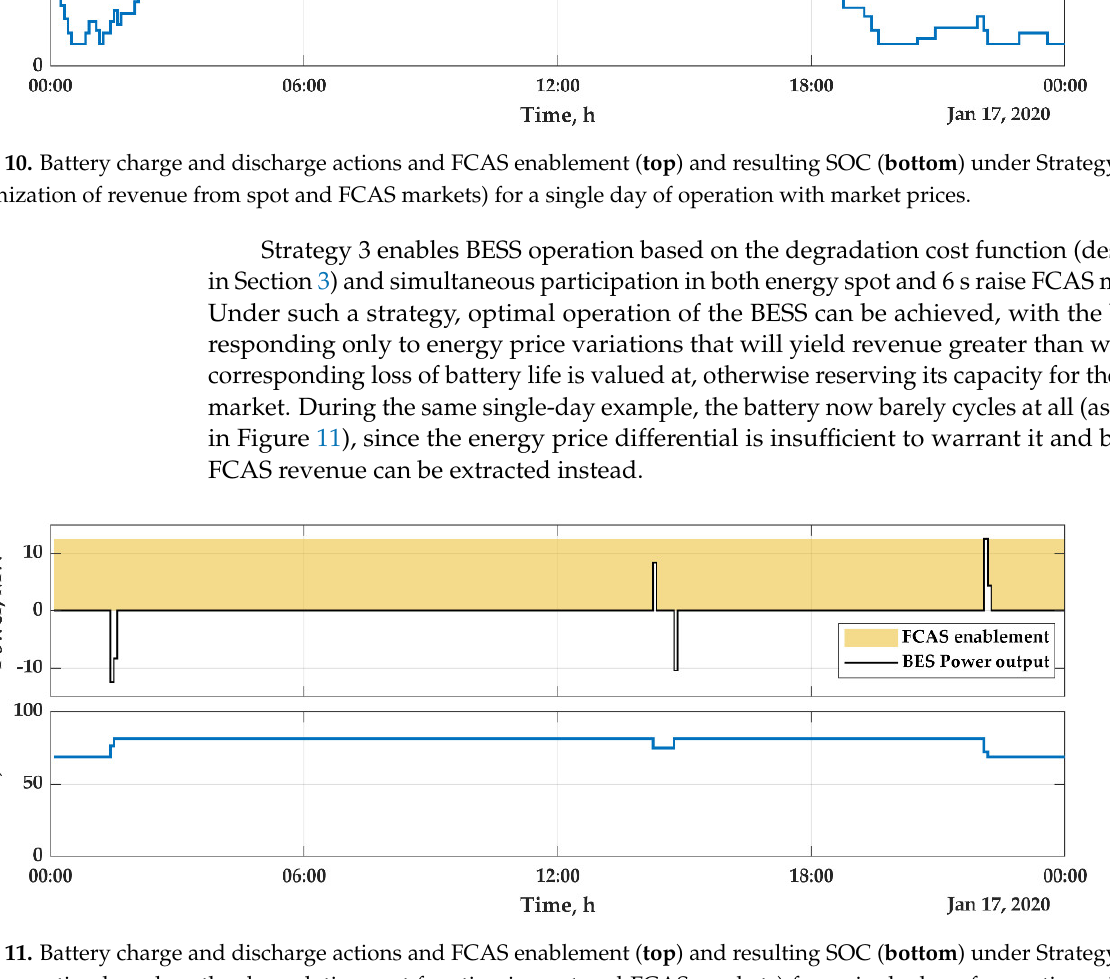
3 (BESS operation based on the degradation cost function in spot and FCAS markets) for a single day of operation with